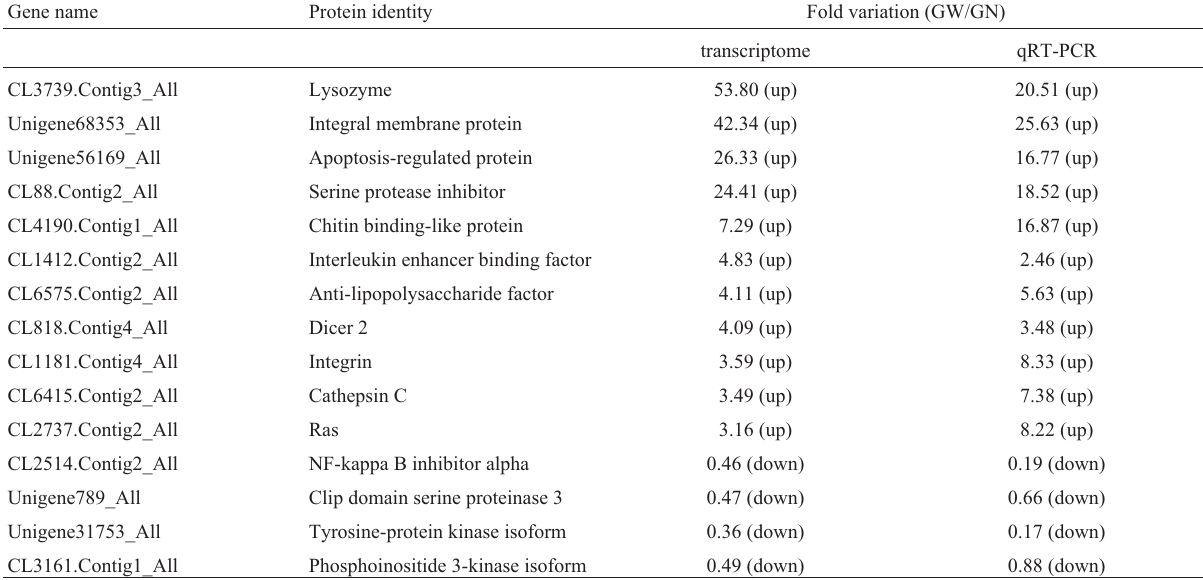
Table 5 - Comparison of relative fold change of RNA-Seq and qRT-PCR results between GW and